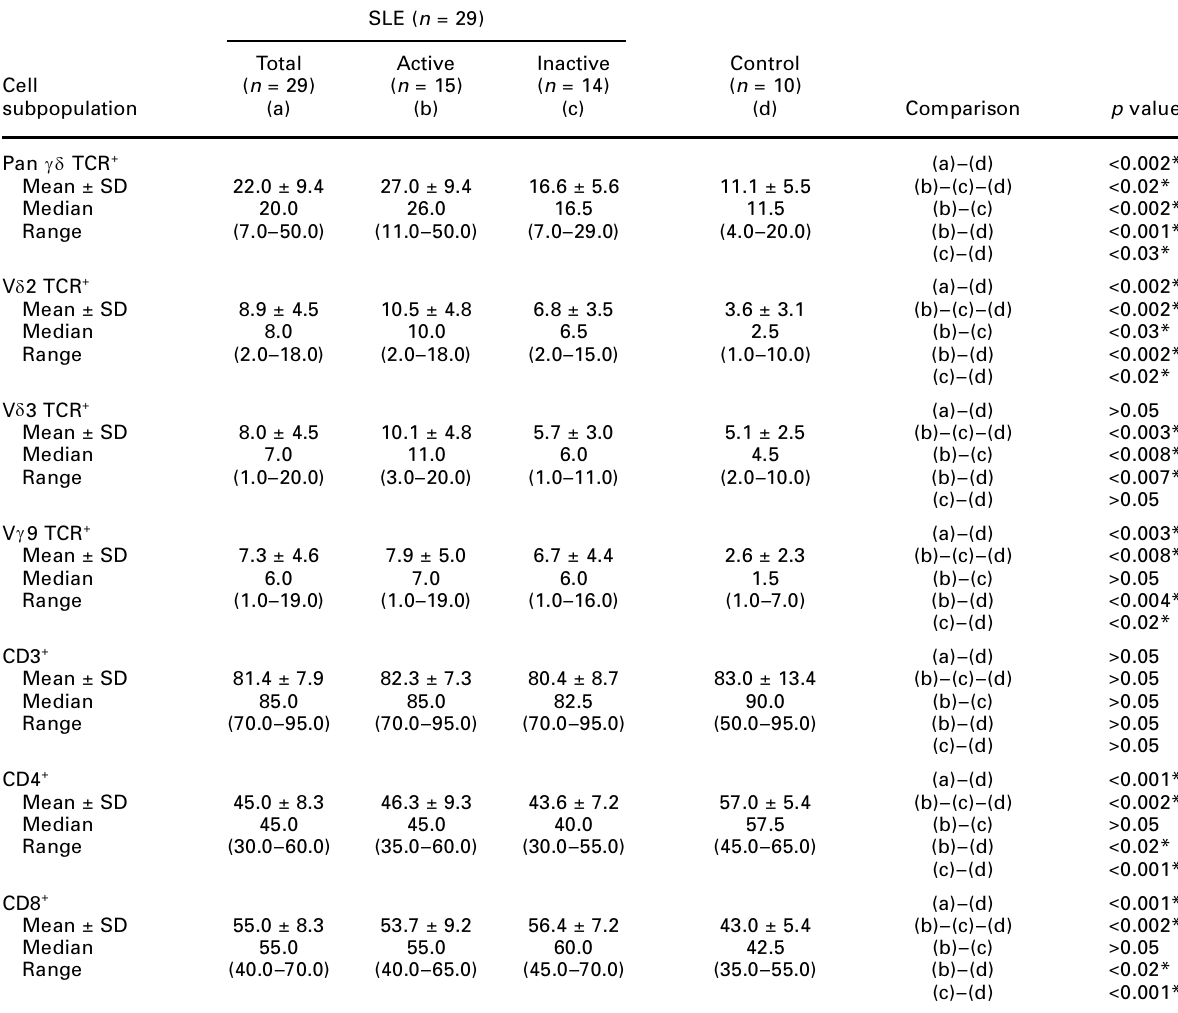
Table 3. Accumulation of g d T cells in normal skin from SLE patients and normal controls (percentage of cells with positive reactions relative to all cells of the infiltrate in the examined visual fields)